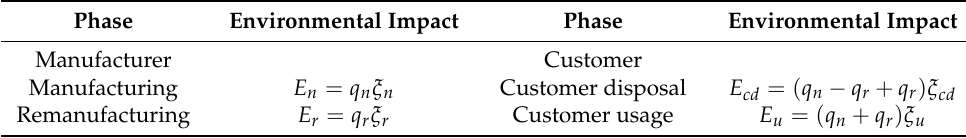
Table 10. Environmental Impact